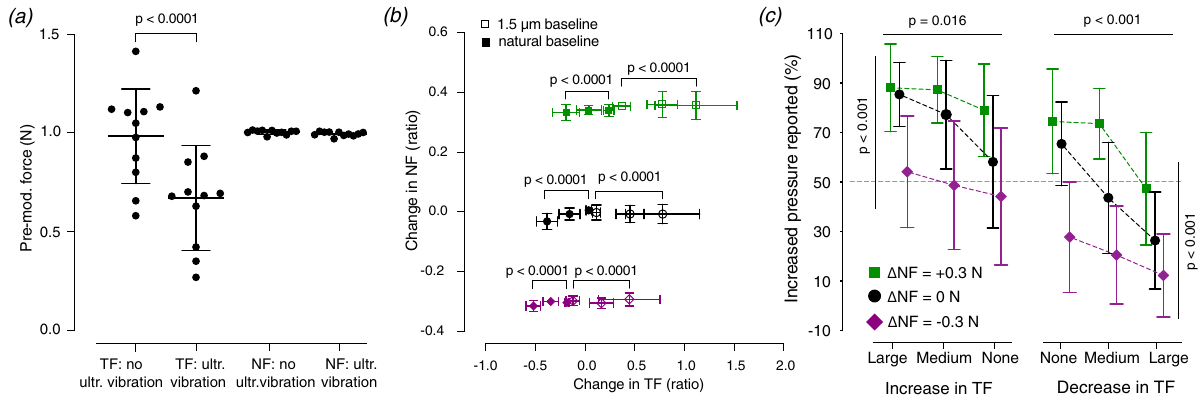
Figure 2. ( a ) The average tangential force (TF) and average normal force (NF) during the pre-modulation interval for all eleven participants in each condition, plus summary statistics (mean ± SD). ( b ) The change in TF and NF averaged across all participants for the 18 conditions of the experiment ( c ) The averaged answers across participants in the 18 conditions of the experiment (mean ± SD) Left: the conditions in which TF increased or stayed constant at a lower level during the modulated interval. Right: the conditions in which TF decreased or stayed constant at its natural higher level during the modulated interval. Binary